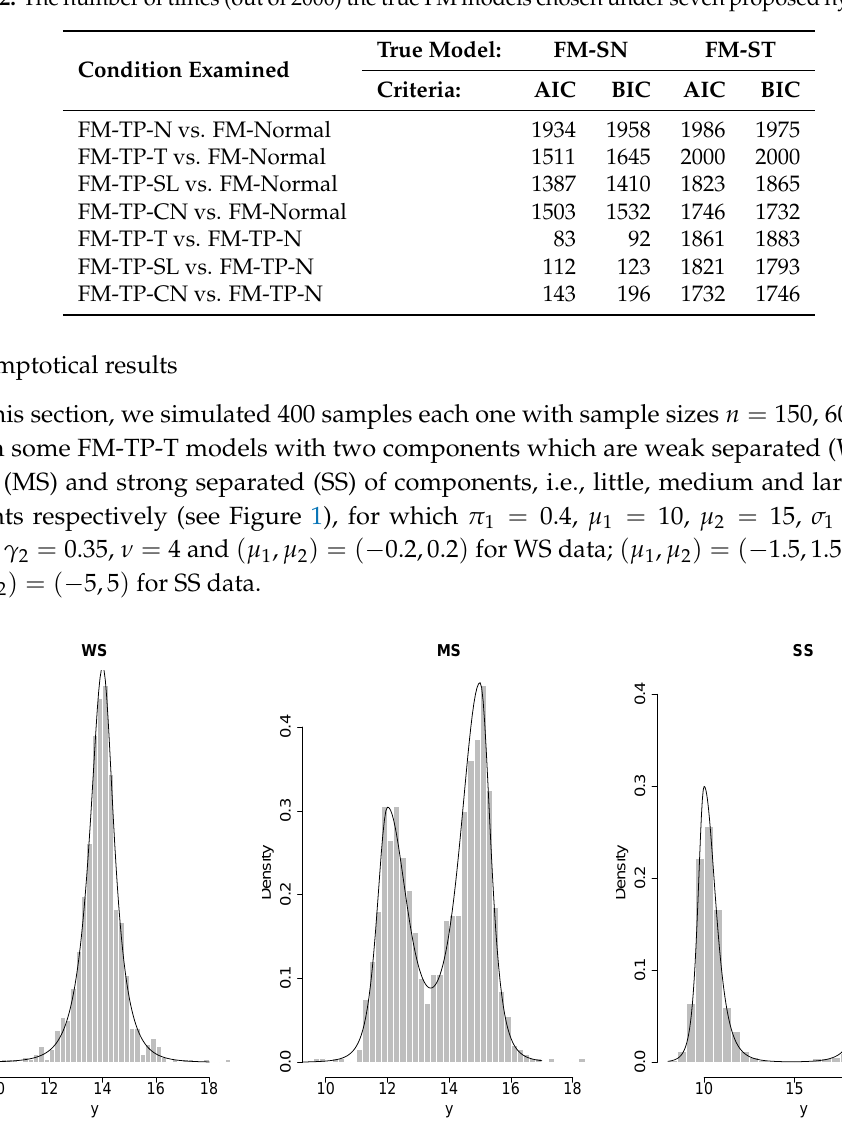
Figure 1. An artificial simulated finite mixture two-piece distributions based on the scale mixtures of normal (FM-TP-SMN) data of length n = 400 with two components: weakly separated components (WS); medium separated components (MS) and strongly separated components (SS), with curved probability density function (PDF) that datasets extracted from